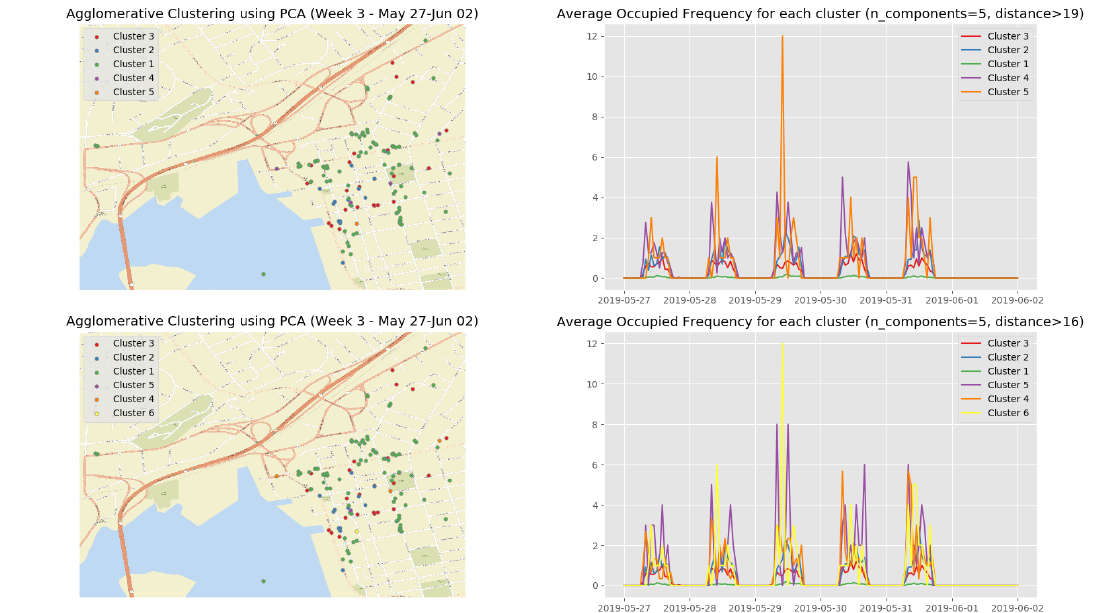
Figure A8. Clustering results using PCA for the 3rd week.